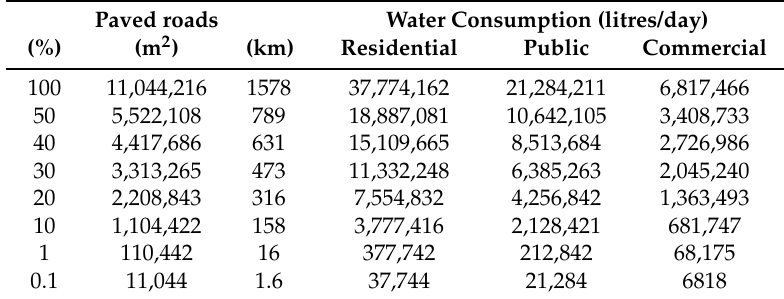
Table 11. Summary of paved roads area and water consumption per sector. Paved